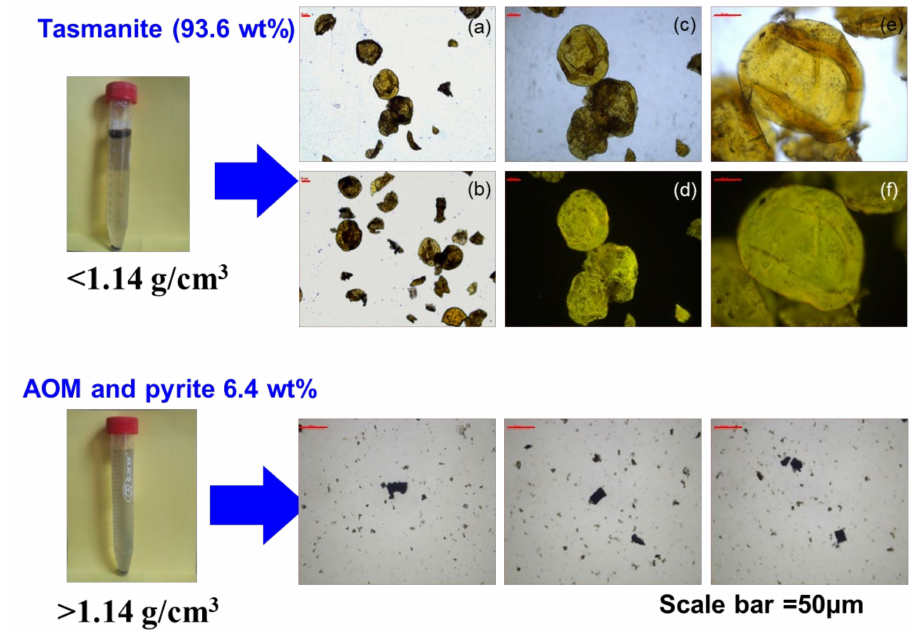
Figure 4. The sink-float separation results of the kerogen isolated from Tasmanite oil shale Aus-2, showing most of the organic matter (93.6 wt%) is Tasmanites algae. Upper panel shows micropho- tographs of palynomorphs. Microphotographs of ( a – c , e ) were taken using transmitted light, while ( d , f ) are fluorescence light, corresponding to ( c , e ), respectively. Scale bar = 50 µ m.